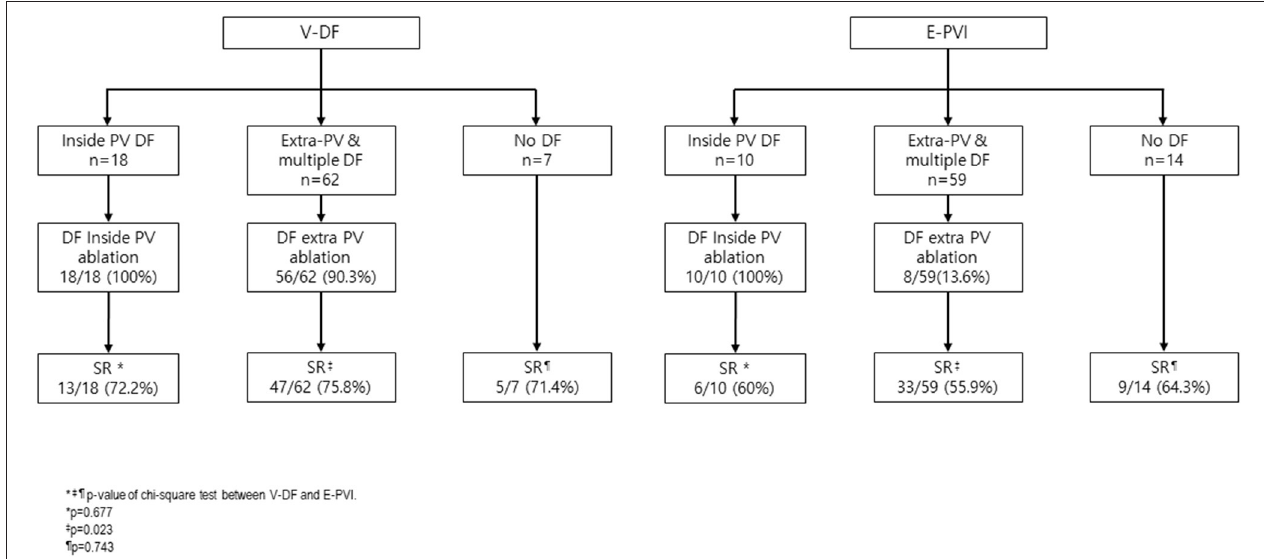
FIGURE 5 | Procedure outcome according to DF location and